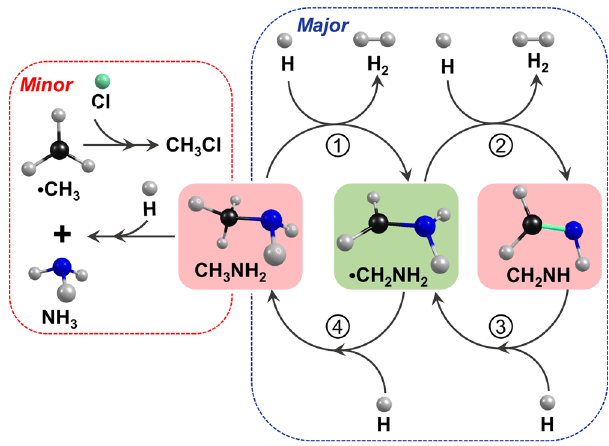
Fig. 4 Dual-cycle mechanism of H-abstraction and H-addition reactions connecting CH 3 NH 2 , • CH 2 NH 2 , and CH 2 NH and the formation of CH 3 and NH 3 . The area on the right with blue dotted boundary represents the major dual-cycle channels connecting CH 3 NH 2 , • CH 2 NH 2 , and CH 2 NH with two sets of H-abstraction and H-addition reactions. The area on the left with red dotted boundary represents minor reactions channels of the decomposition of CH 3 NH 2 to form CH 3 and NH 3 upon H